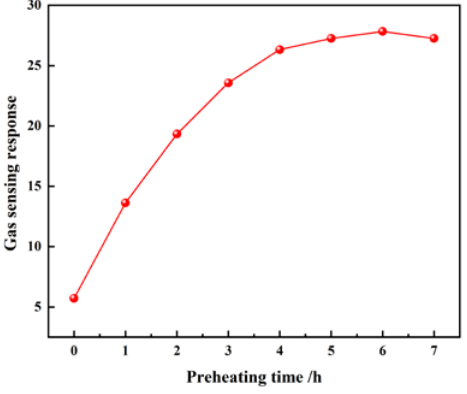
Figure 3. Preprocessing time curve of S3 composite material at 15 μL/L C 2 H 2 .